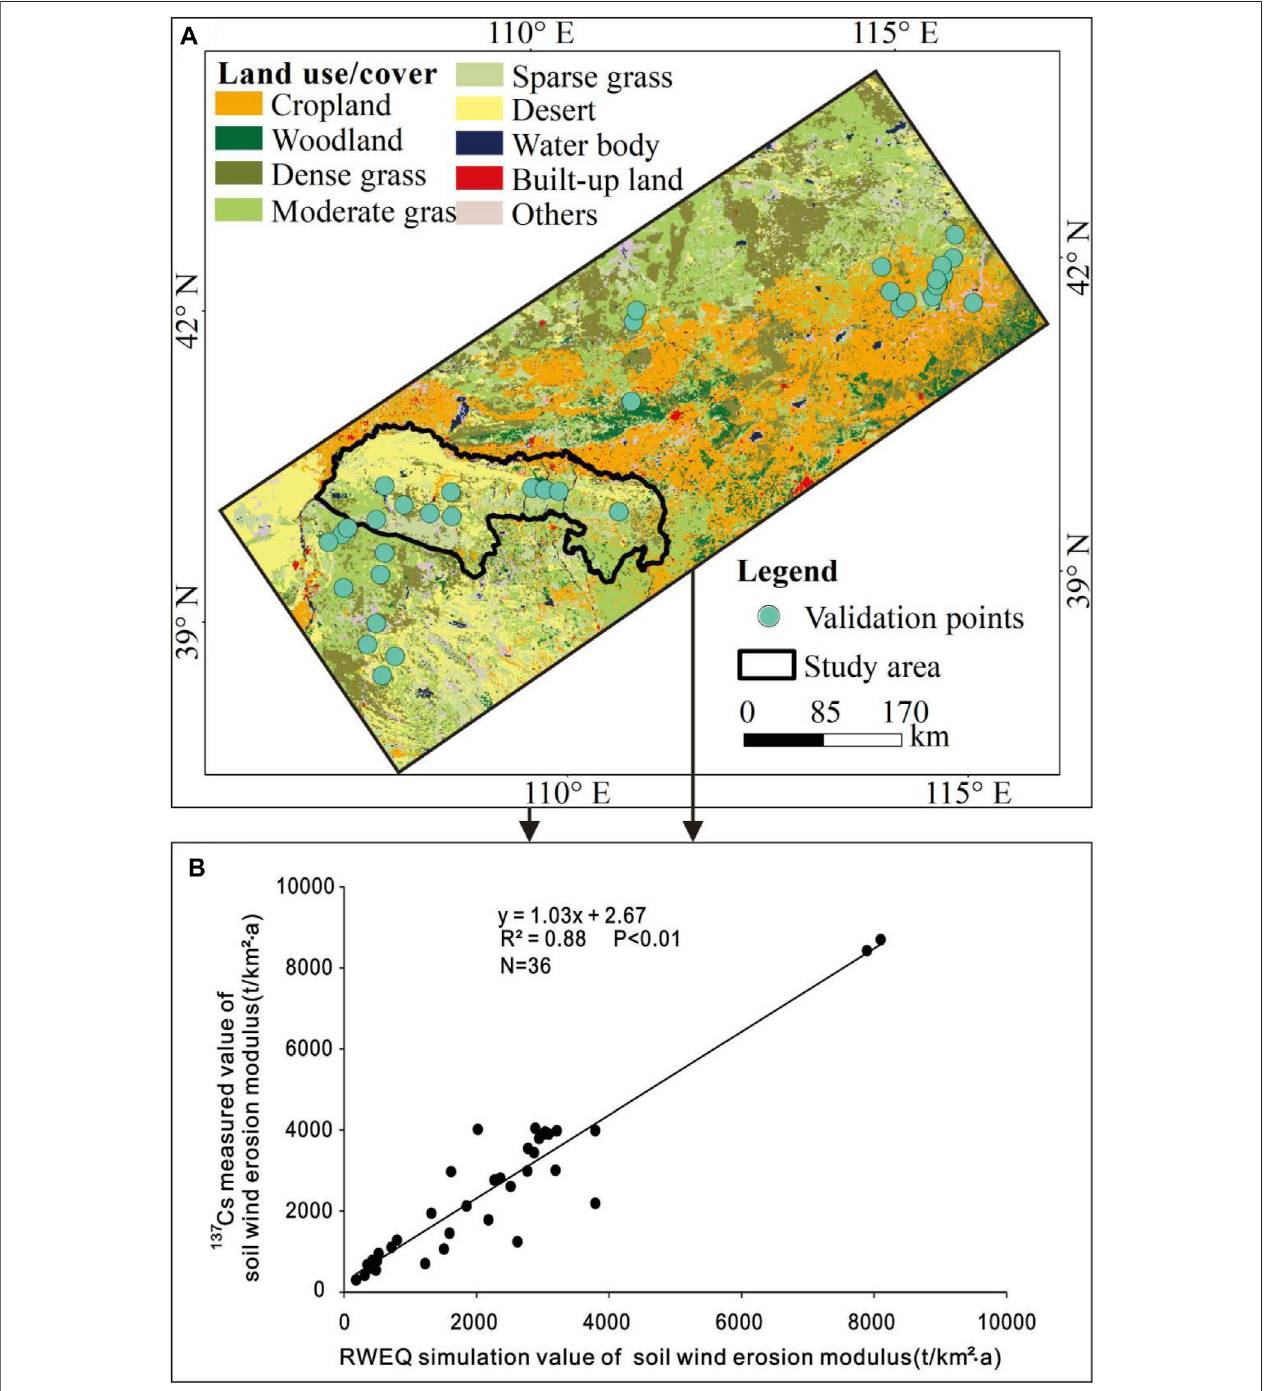
FIGURE 4 | Field sampling veri fi cation of the soil – wind erosion modulus. (A) : Distribution of fi eld sampling veri fi cation points, (B) : RWEQ simulation value of the soil – wind erosion modulus.